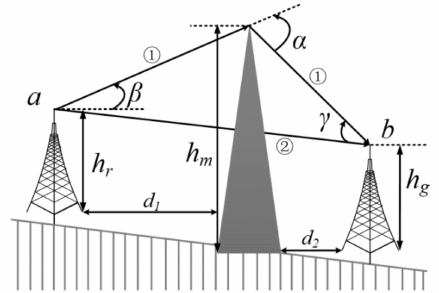
Figure 3. Principle of wireless signal di ff